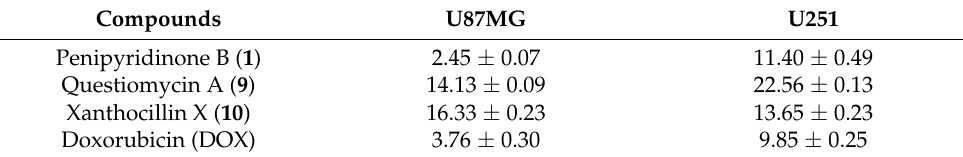
Table 4. Activity of compounds in inhibiting the proliferation of glioma cells (IC 50 : µ M). Compounds